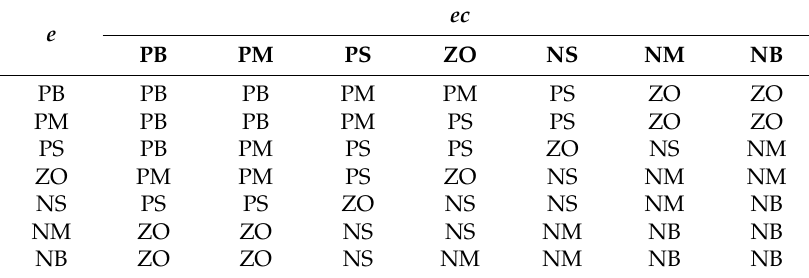
Table 3. Fuzzy control rule table of (cid:52) k i .